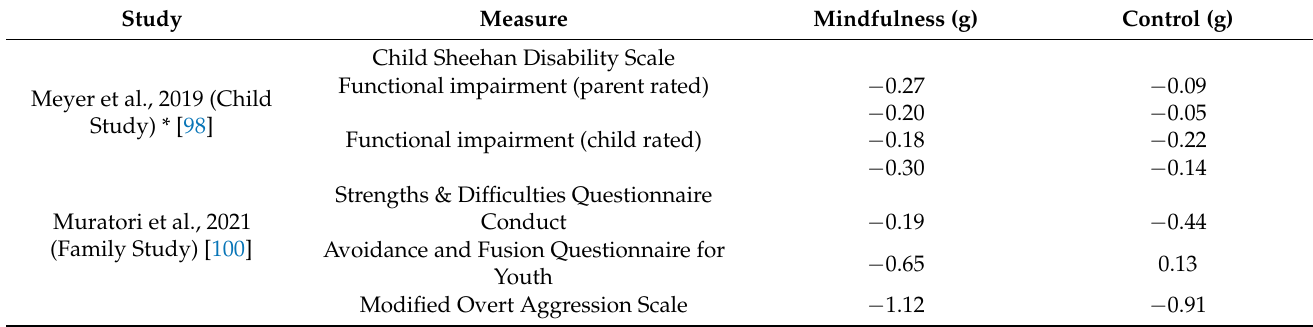
Table 9. Effect sizes for general behavioural measures employed in individual